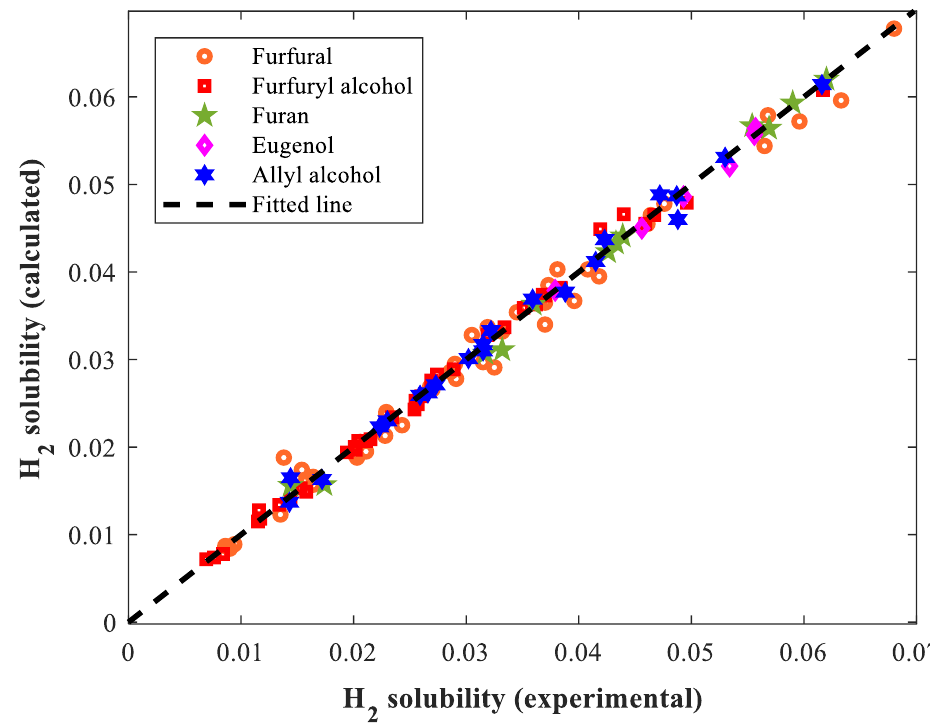
Figure 6. The model predictions versus actual measurements of hydrogen solubility in biomaterials.